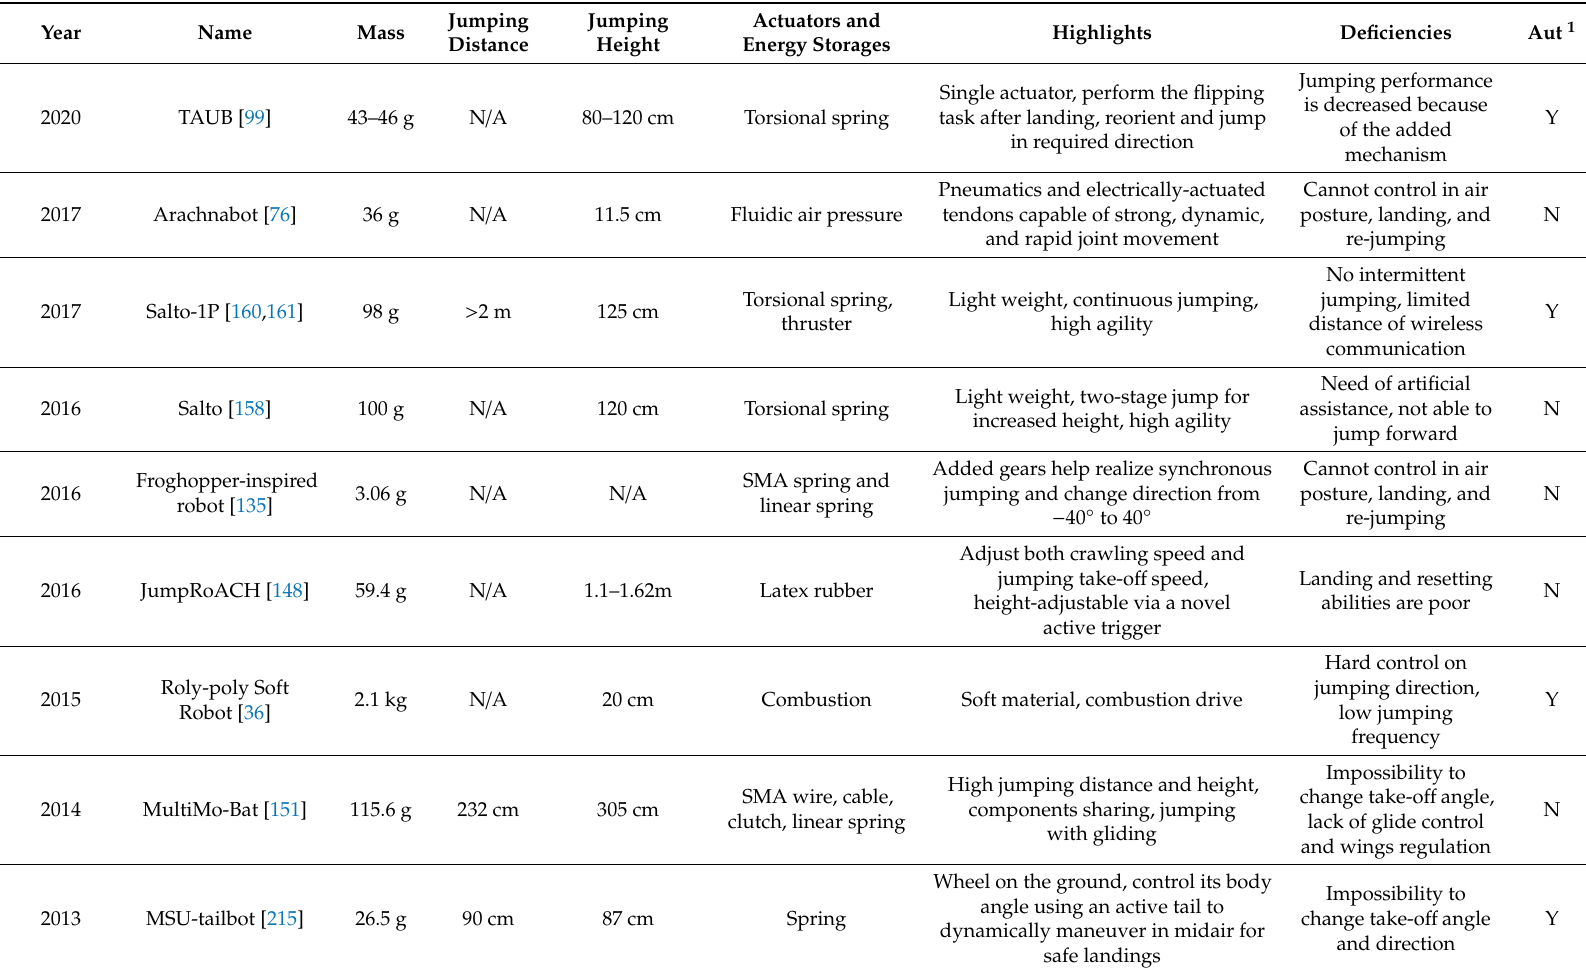
Table 2. Performance comparisons of existing invertebrate animals inspired jumping